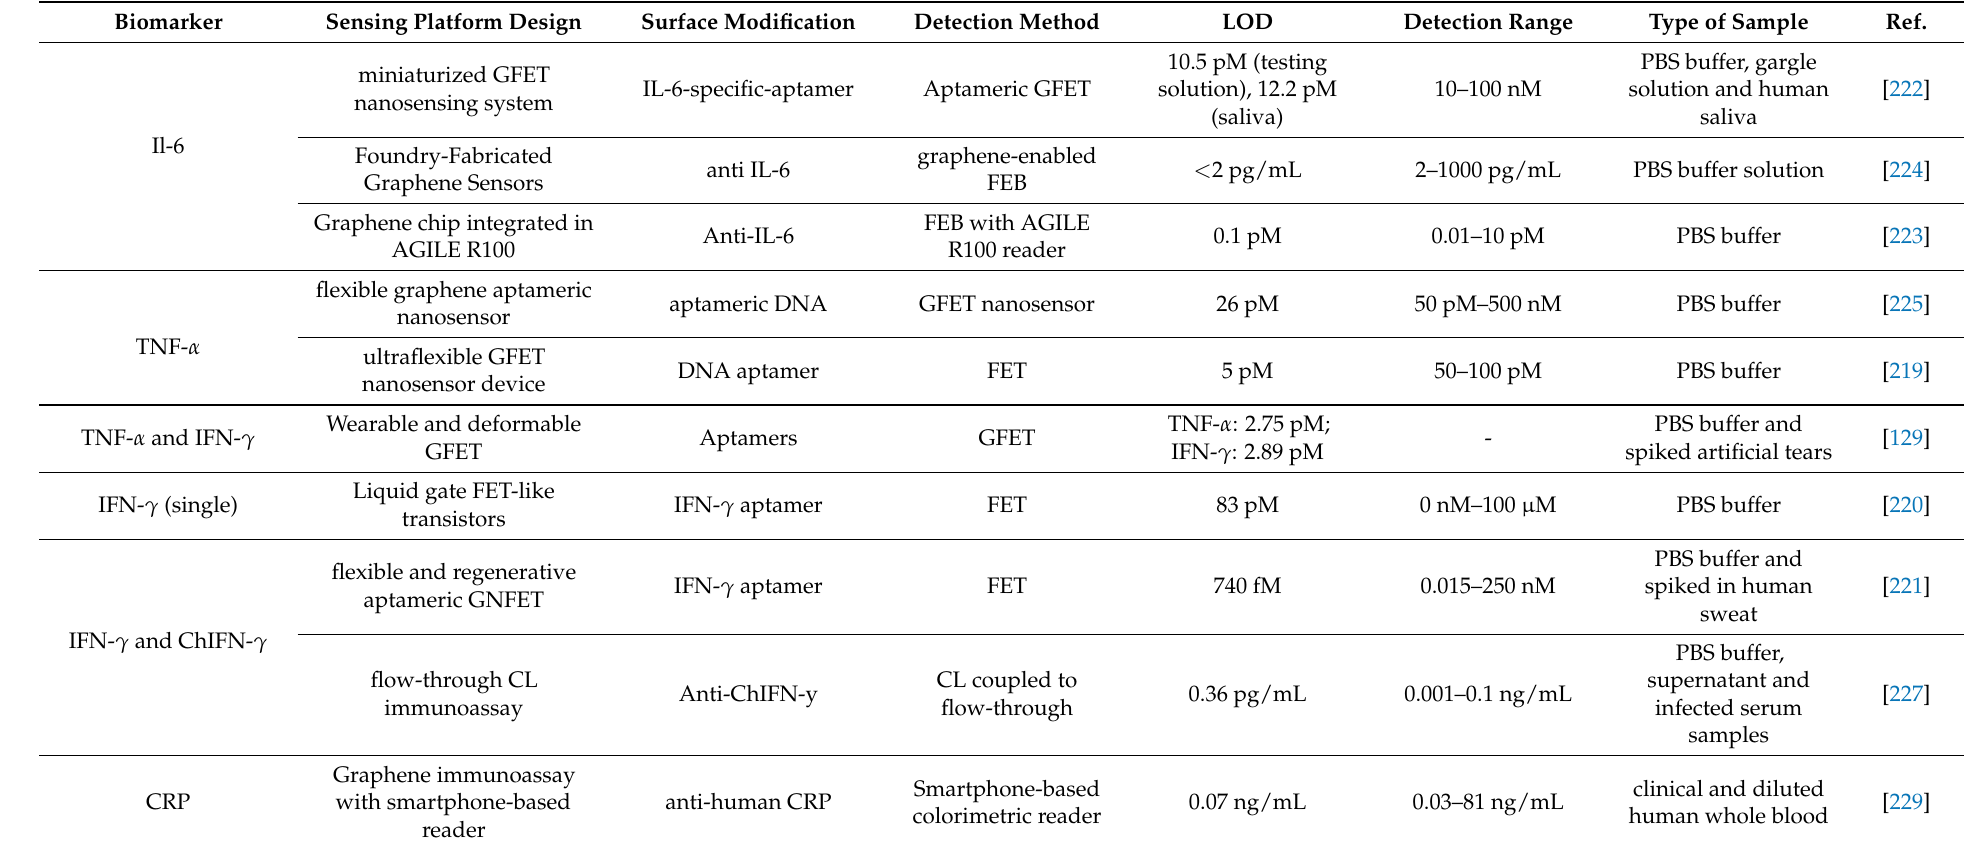
Table 4. Summary of wearable-remote-portable biosensors assisted with GDMs for detection of inflammatory disease